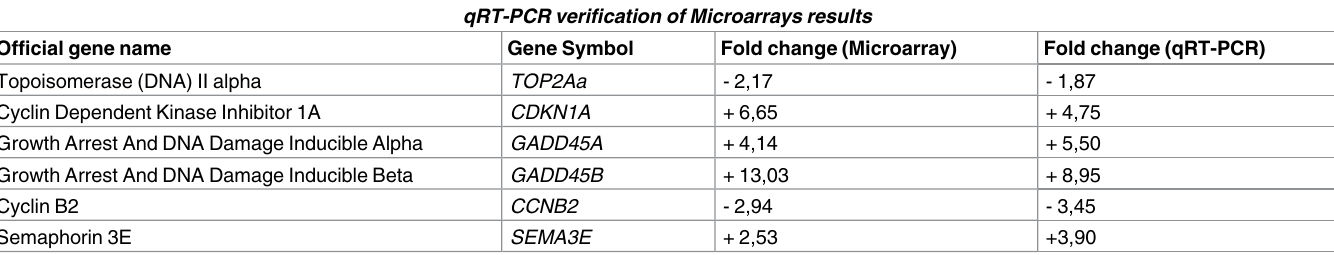
Table 1. Confirmation of microarraygene expression results with Rt-PCR.